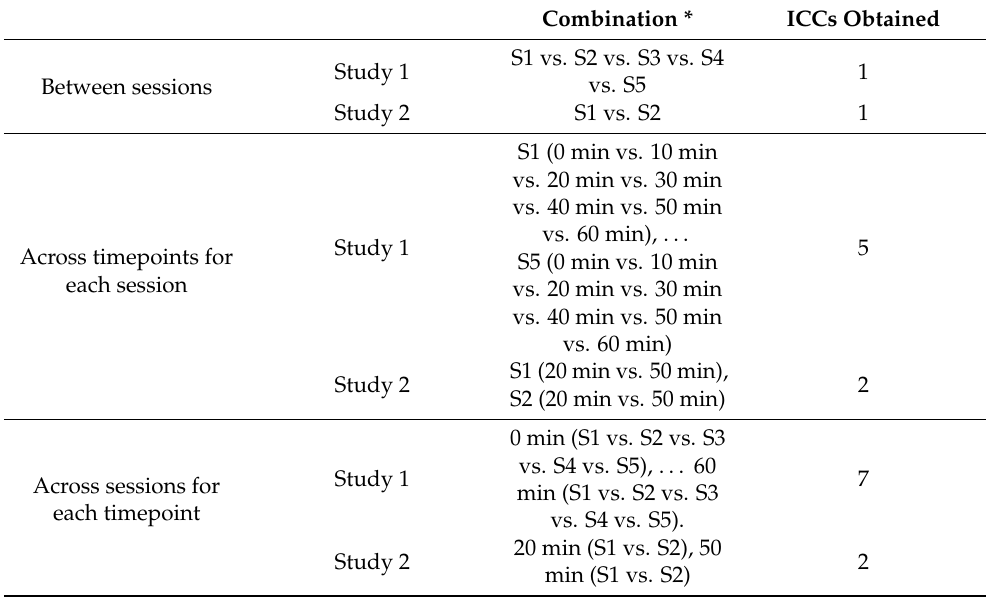
Table 1. Illustration of the combinations used to calculate ICCs.